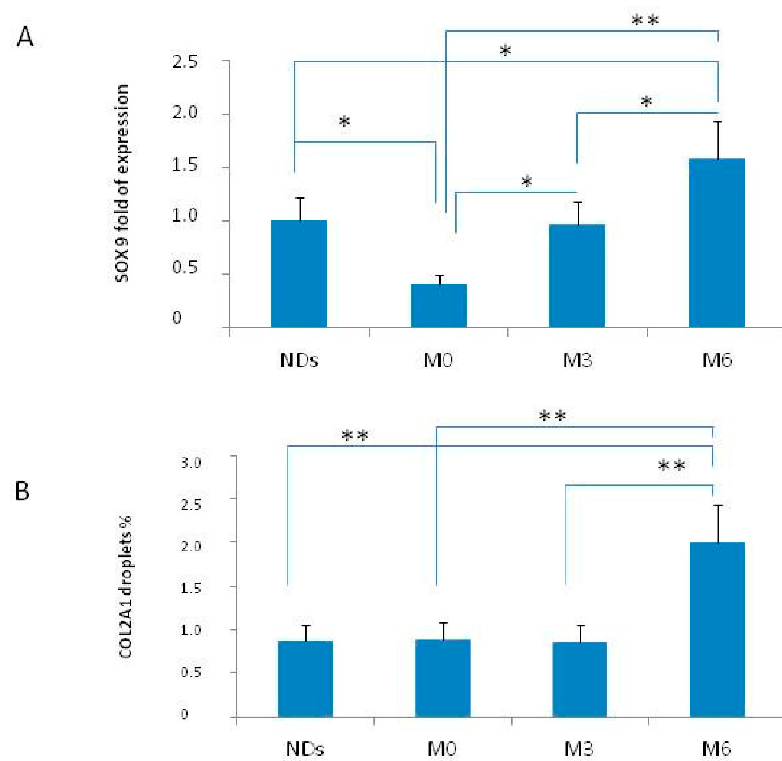
Figure 1. SOX9 ( A ) and COL2A1 ( B ) fold of expression in CPCs of Normal Donors (NDs) and patients at baseline (M0), after 3 (M3) and 6 (M6) months. * p < 0.05; ** p <